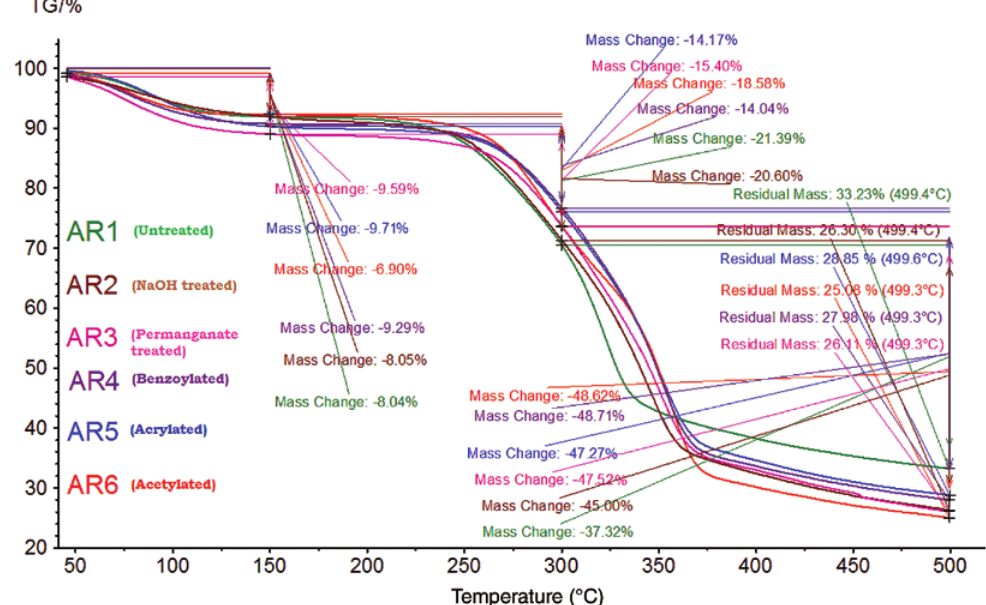
Figure 6: Thermogravimetric analysis (TGA) of untreated and all chemically treated areca fibers.